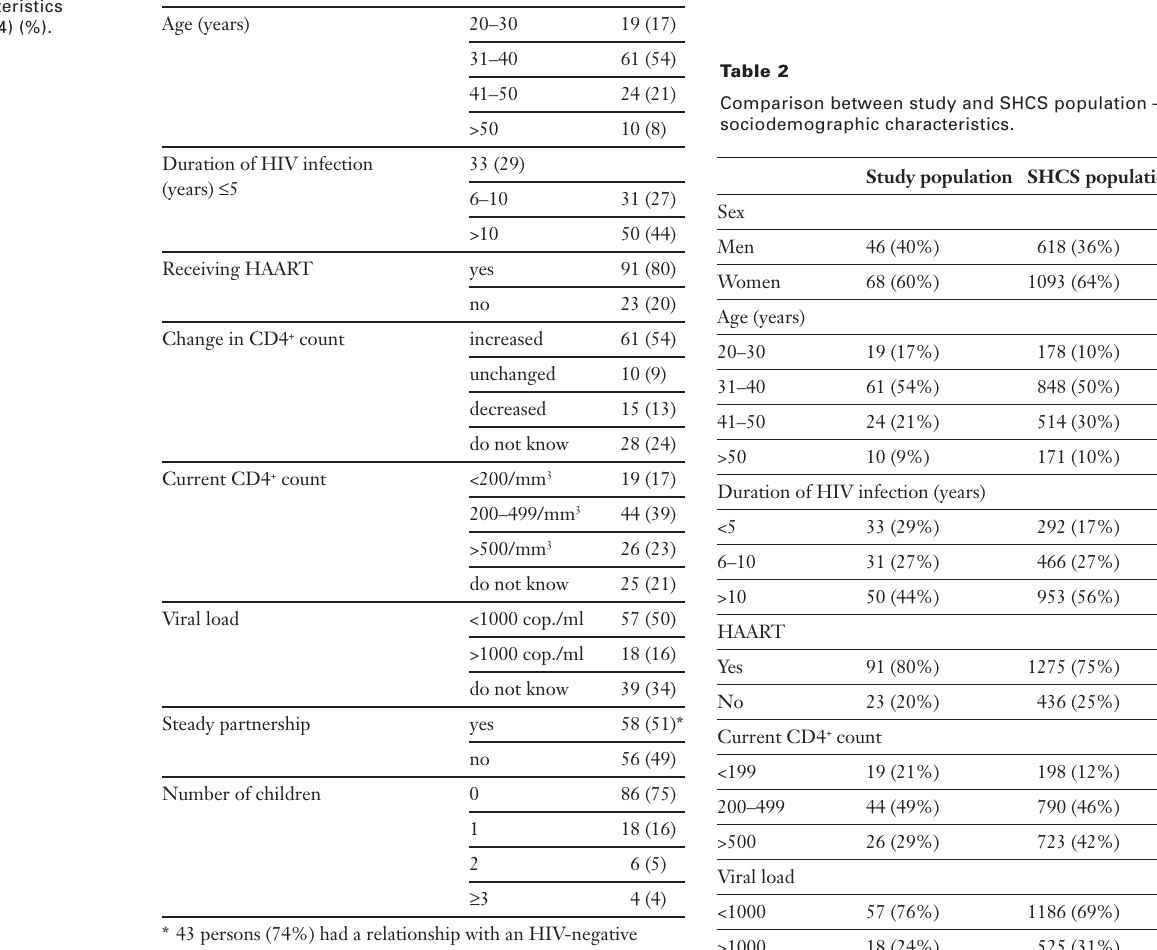
Sociodemographic characteristics (n = 114) (%).